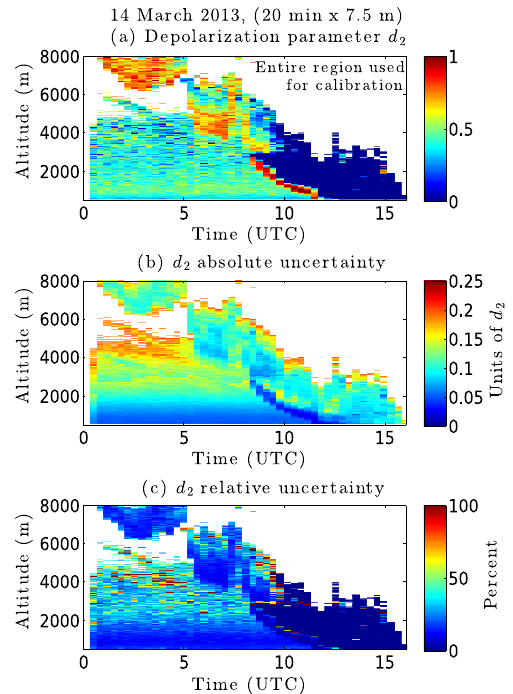
Figure 17. (a) The d 2 depolarization values from 14 March 2013, using only clear-sky and regular cloud data (thick clouds excluded) to influence the calibration profile. (b) The uncertainties associ- ated with the d 2 values are all in units of depolarization parameter. (c) The relative uncertainties are in units of